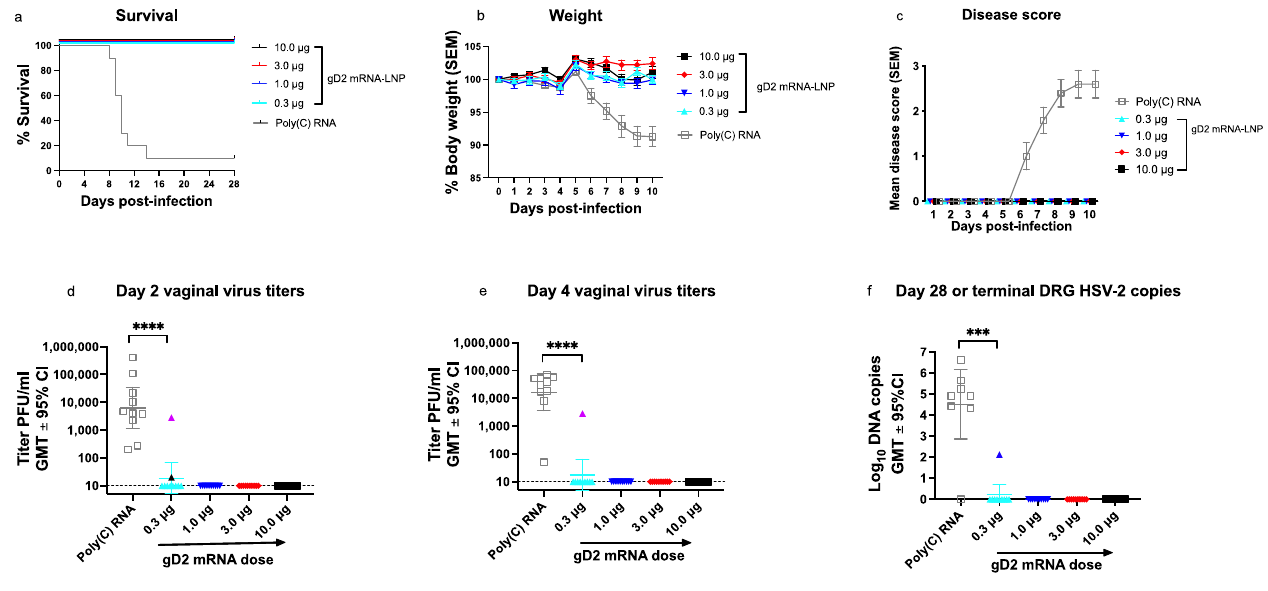
Figure 5. Vaccine efficacy in mice immunized with gD2 mRNA-LNP. ( a ) Survival curves: p < 0.0001 comparing the Poly(C) RNA group with all other groups. ( b ) Mean weight on days 1–10 post-infection. ( c ) Mean genital disease scores on days 1–10 post-infection. ( d ) Vaginal swab virus titers on day 2 post-infection ( e ) Vaginal swab virus titers on day 4 post-infection. The purple triangle symbol in ( d , e ) indicate that the vaginal virus titer is from the same animal. Dotted line in ( d , e ) indicates the assay limit of detection of 10 PFU/mL. ( f ) HSV-2 DNA copy number in dorsal root ganglia (DRG) at the time of euthanasia for the Poly(C) RNA group or at the end of the experiment on days